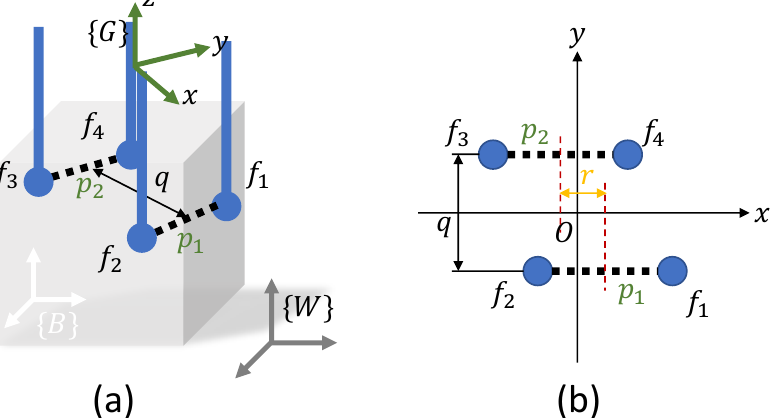
Figure 3. Illustration of the four-pin gripper and the grasping model. ( a ) The gripper pins and the object to grasp. ( b ) The 2D view of the gripper parameters p 1 , p 2 , q and r